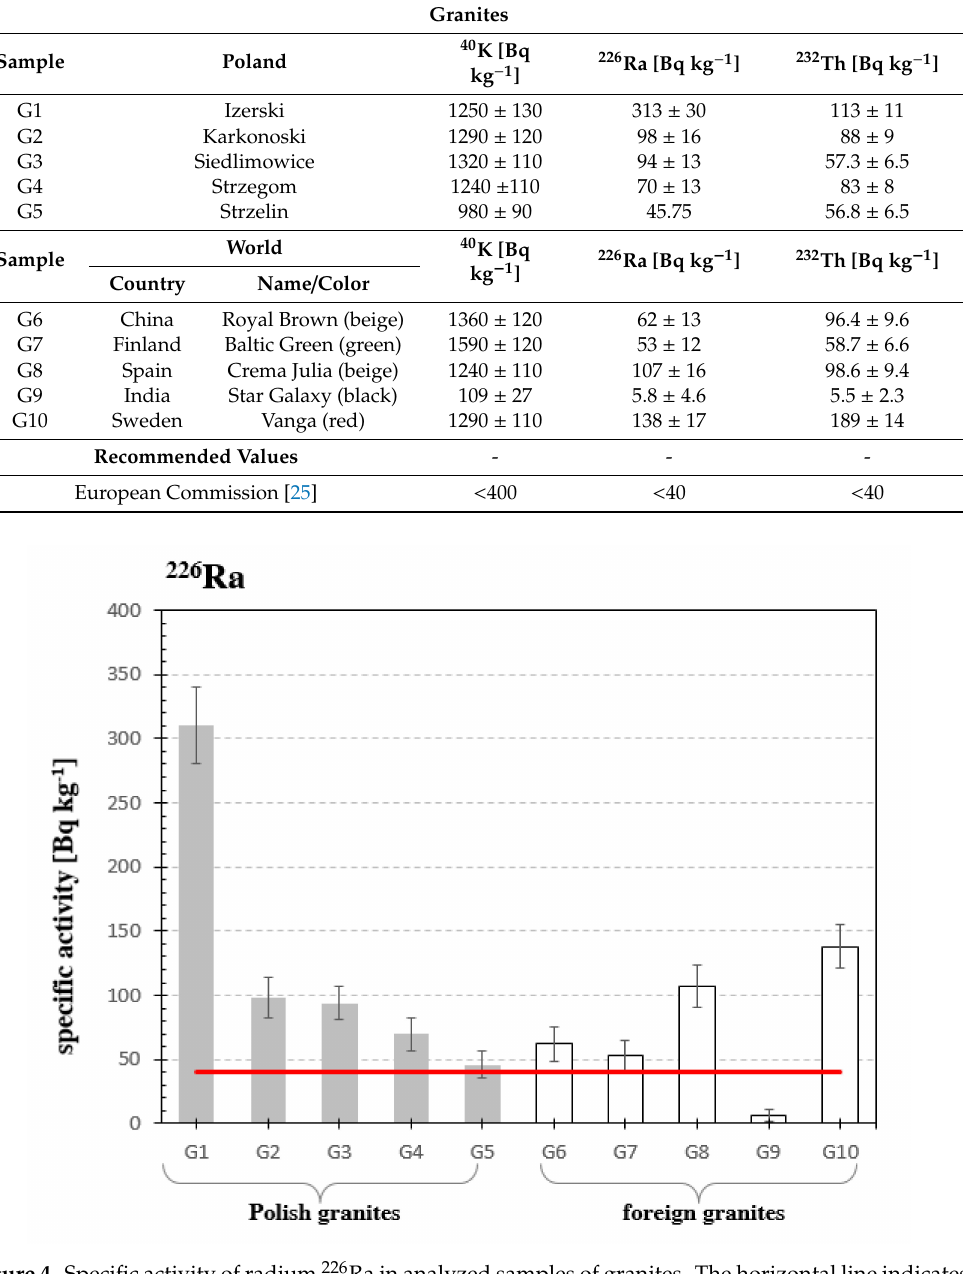
Figure 4. Specific activity of radium 226 Ra in analyzed samples of granites. The horizontal line indicates the average specific activity of 226 Ra of building materials recommended by the European Commission in the Report [25] of 40 Bq · kg − 1